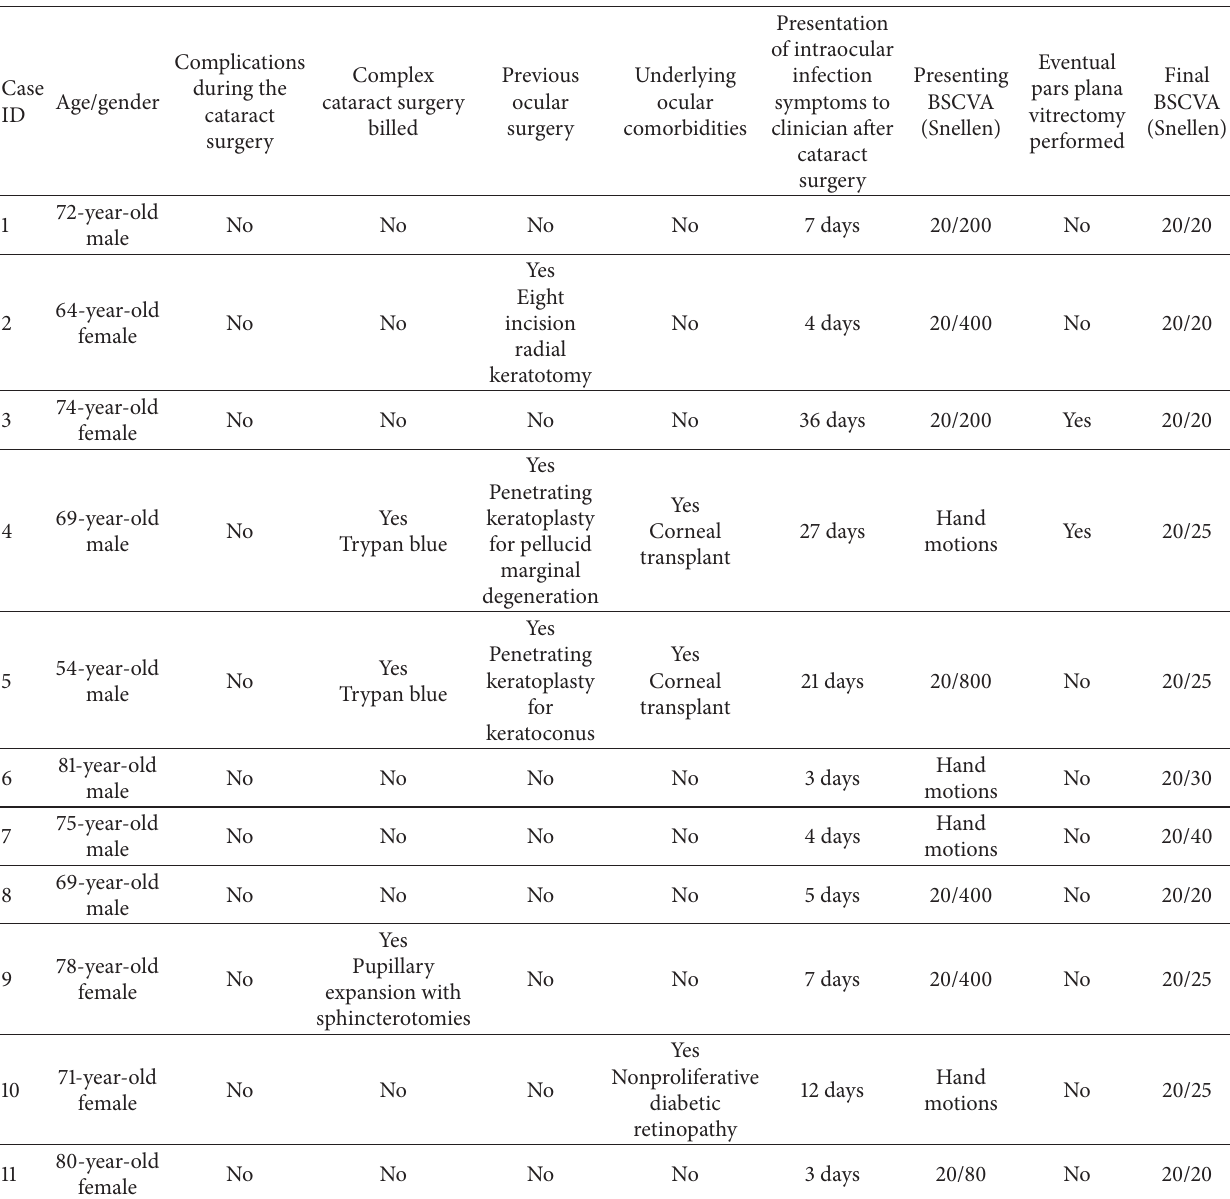
Table 3: Summary of the characteristics and outcomes of subjects developing postoperative endophthalmitis in the cohort that did not receive intracameral